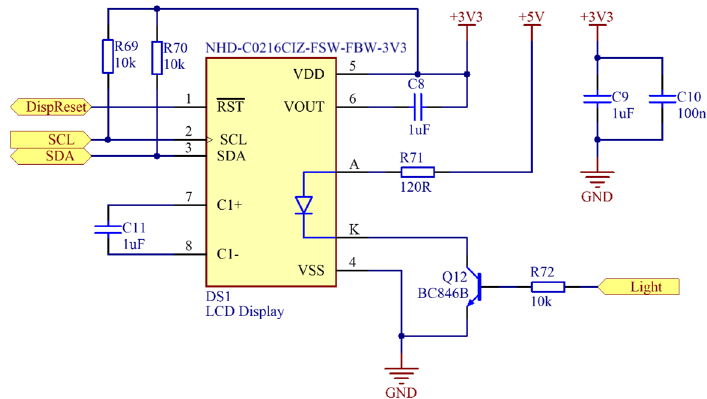
Figure 7. Display schematic sheet.